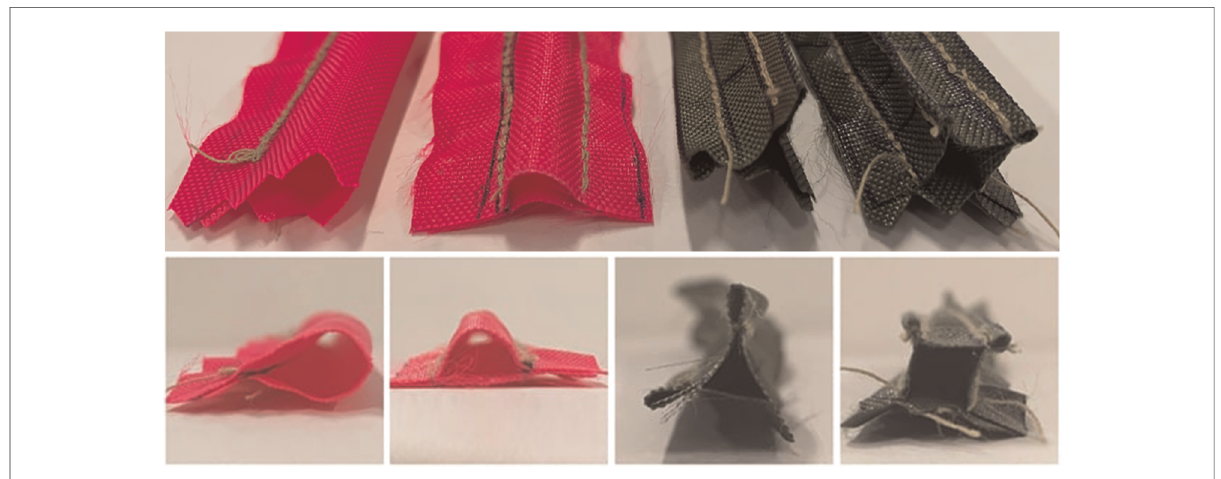
FIGURE 1 The top view (top) and front view (bottom) of the preliminary channel prototypes to test different channel shapes. From left to right the shapes tested include the following: circle, semi-circle, triangle, and